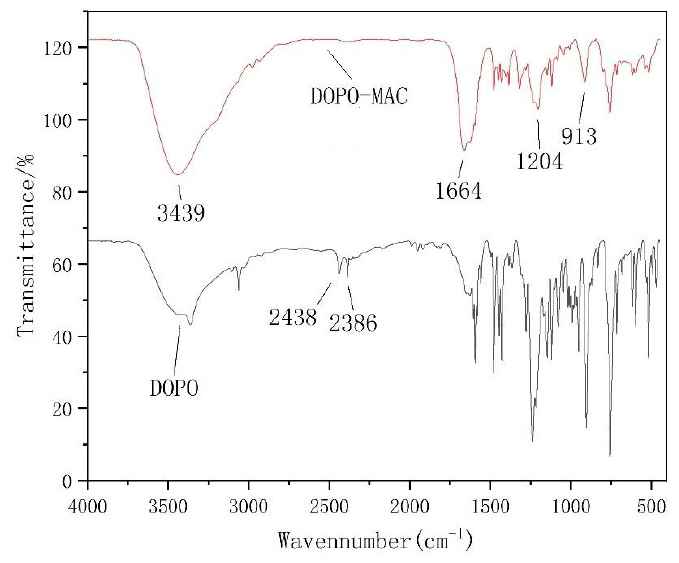
Figure 2. FT-IR of DOPO and DOPO-MAC.